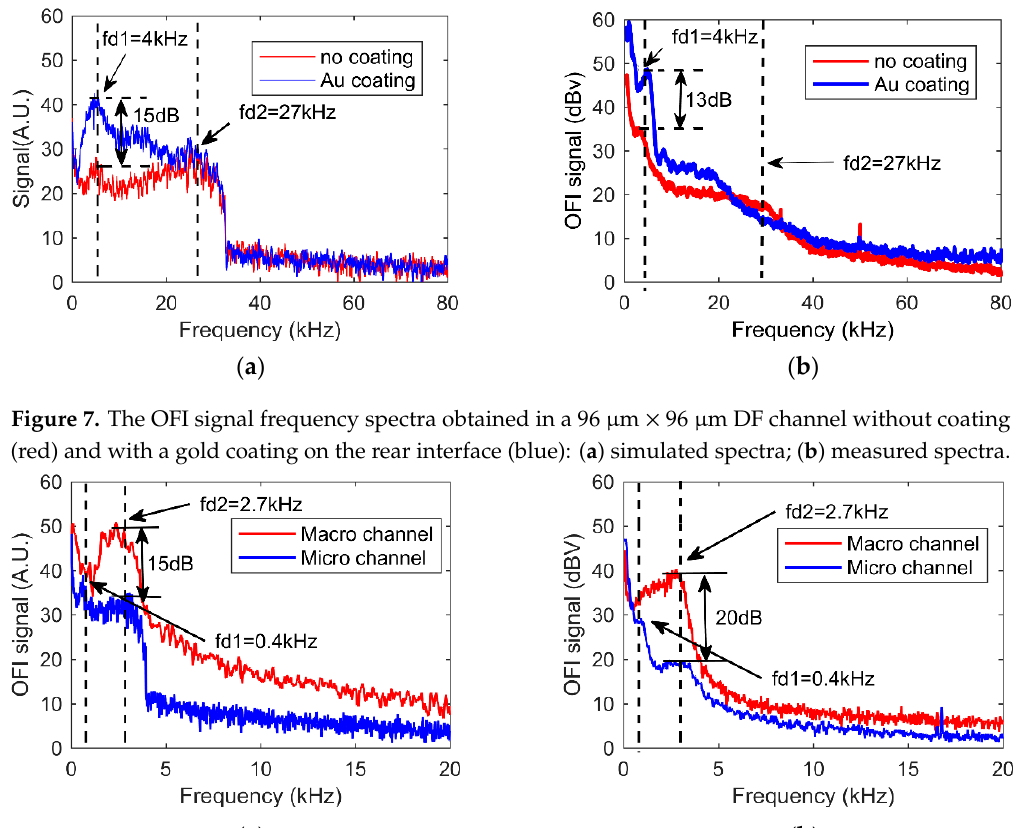
Figure 7. The OFI signal frequency spectra obtained in a 96 µm × 96 µm DF channel without coating (red) and with a gold coating on the rear interface (blue): ( a ) simulated spectra; ( b ) measured spectra.